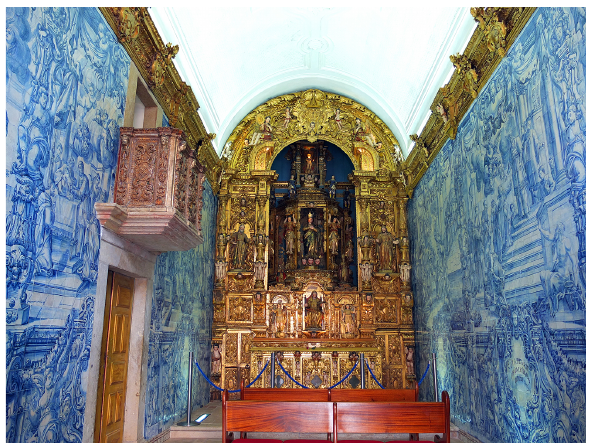
Figure 2. Loulé, Chapel of Our Lady of Conceição, second quarter of the 18 th century. Photo by Jorge Guerra Maio Many existing projects focus on the development of information systems applied to cultural heritage, in the fields of conservation, digital photography, or 3D reconstruction and cataloguing, among others (3). The aim of the present